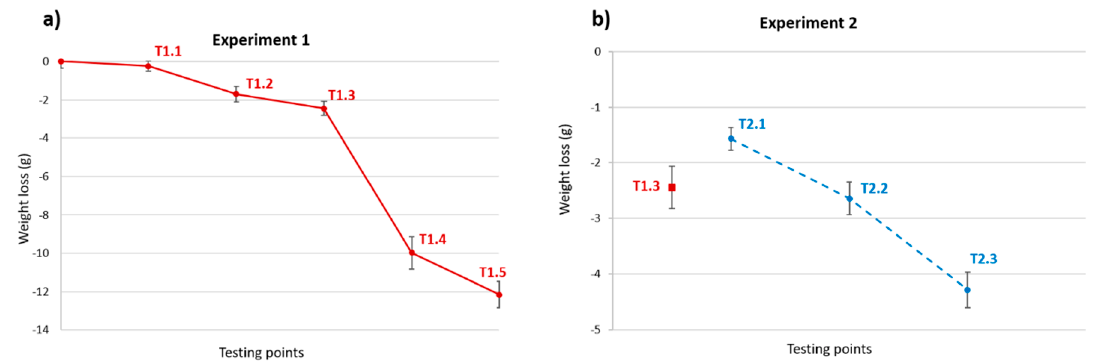
Figure 7. Weight loss in the di ff erent testing points for both thermal treatments. ( a ) Experiment 1; ( b ) Experiment 2.